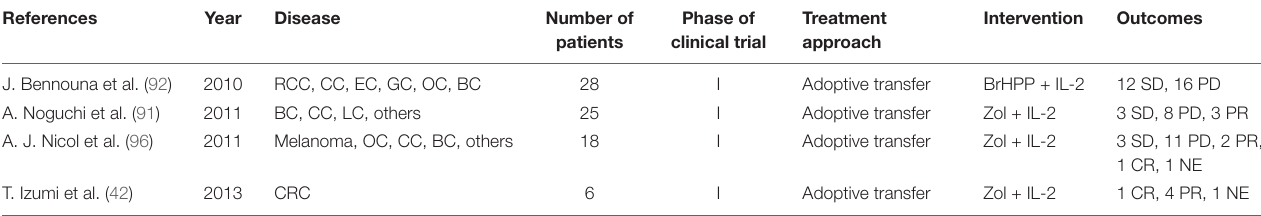
TABLE 1 | Clinical trials using γδ T